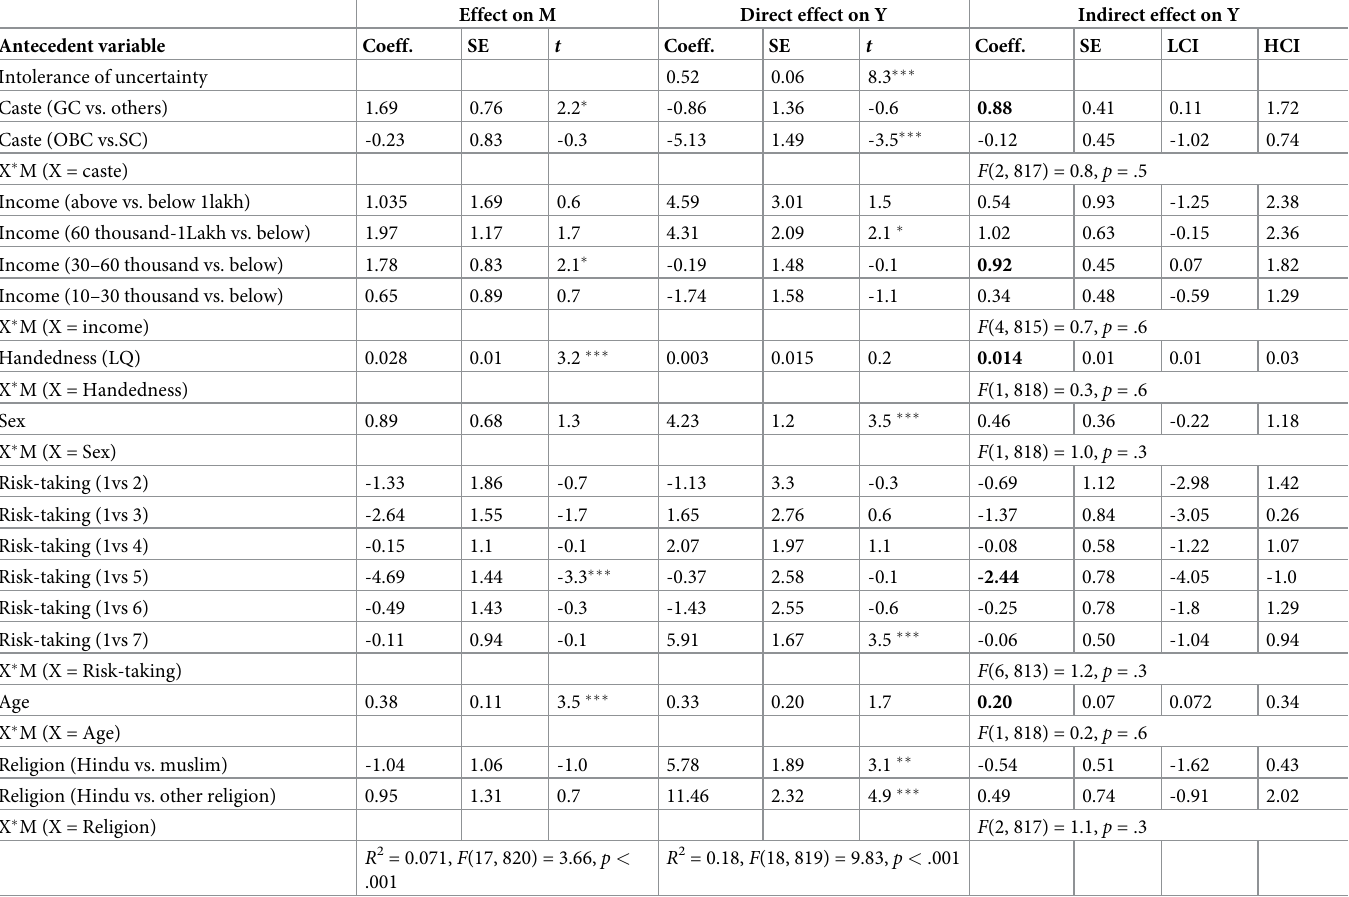
Table 2. The effects (direct and indirect effects) of antecedent variables on the mediation variable (general IU) and the dependent variable (religiousness) in the stu- dents